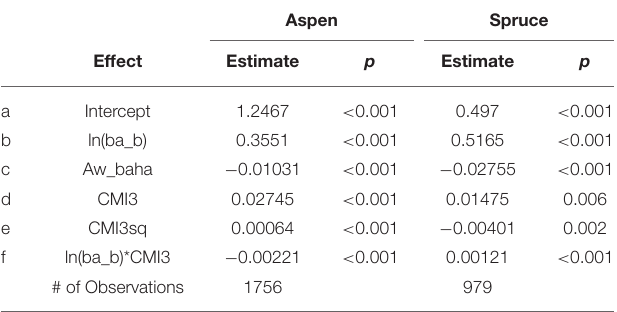
TABLE 4 | Results for models describing variation in annual basal area increment of cored aspen and spruce trees for the 2007–2017 period. Aspen